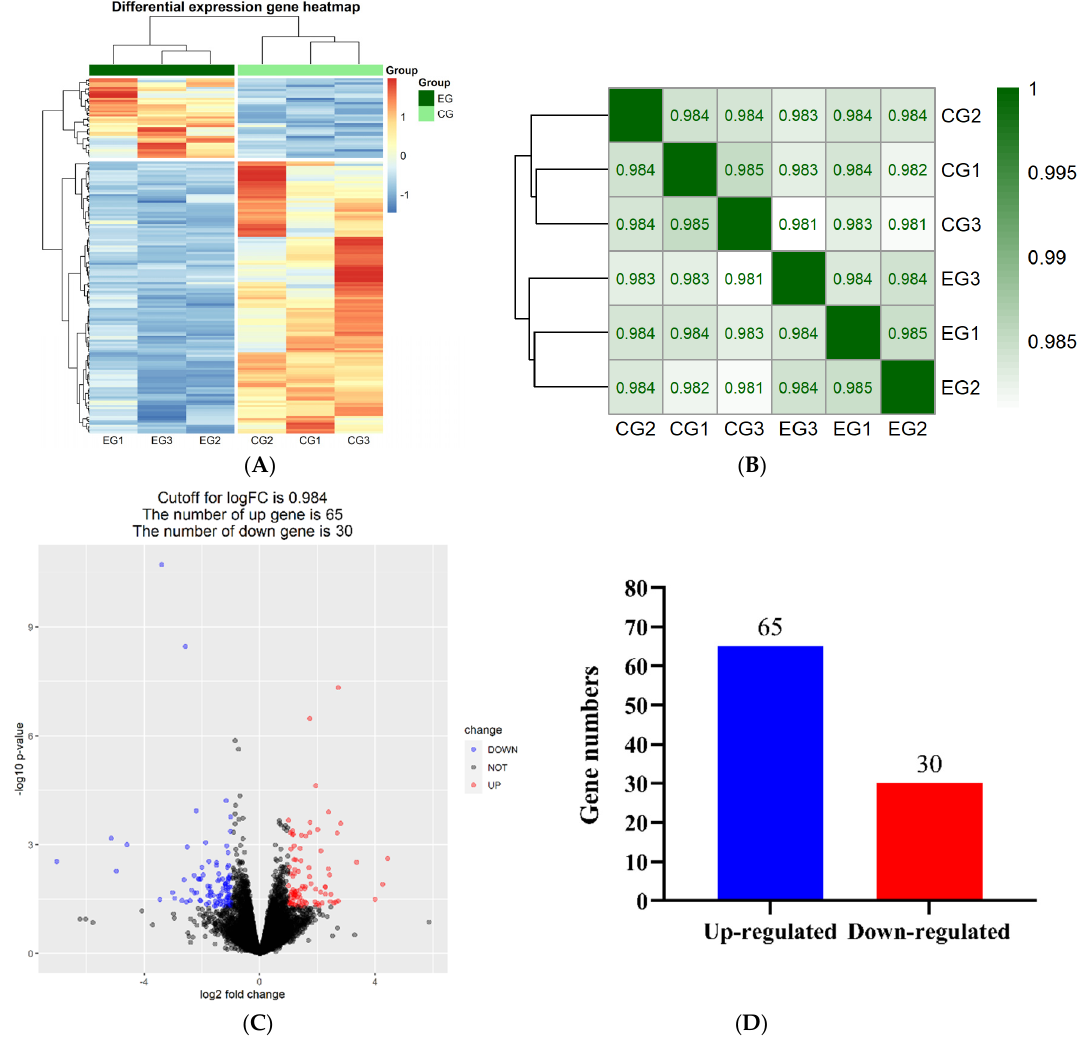
Figure 1. Analysis of differentially expressed genes. ( A ) Clustering analysis of DEGs between EG and CG. ( B ) Correlation matrix diagram between EG and CG; the correlation coefficient is represented by color—the darker the color of green, the higher the correlation. ( C ) Volcano plot of DEGs between EG and CG; blue and red represent downregulated and upregulated DEGs, respectively. ( D ) Statistics of the DEGs between EG and CG. EG: high-addition group, CG: control group, and DEGs: differentially expressed genes.